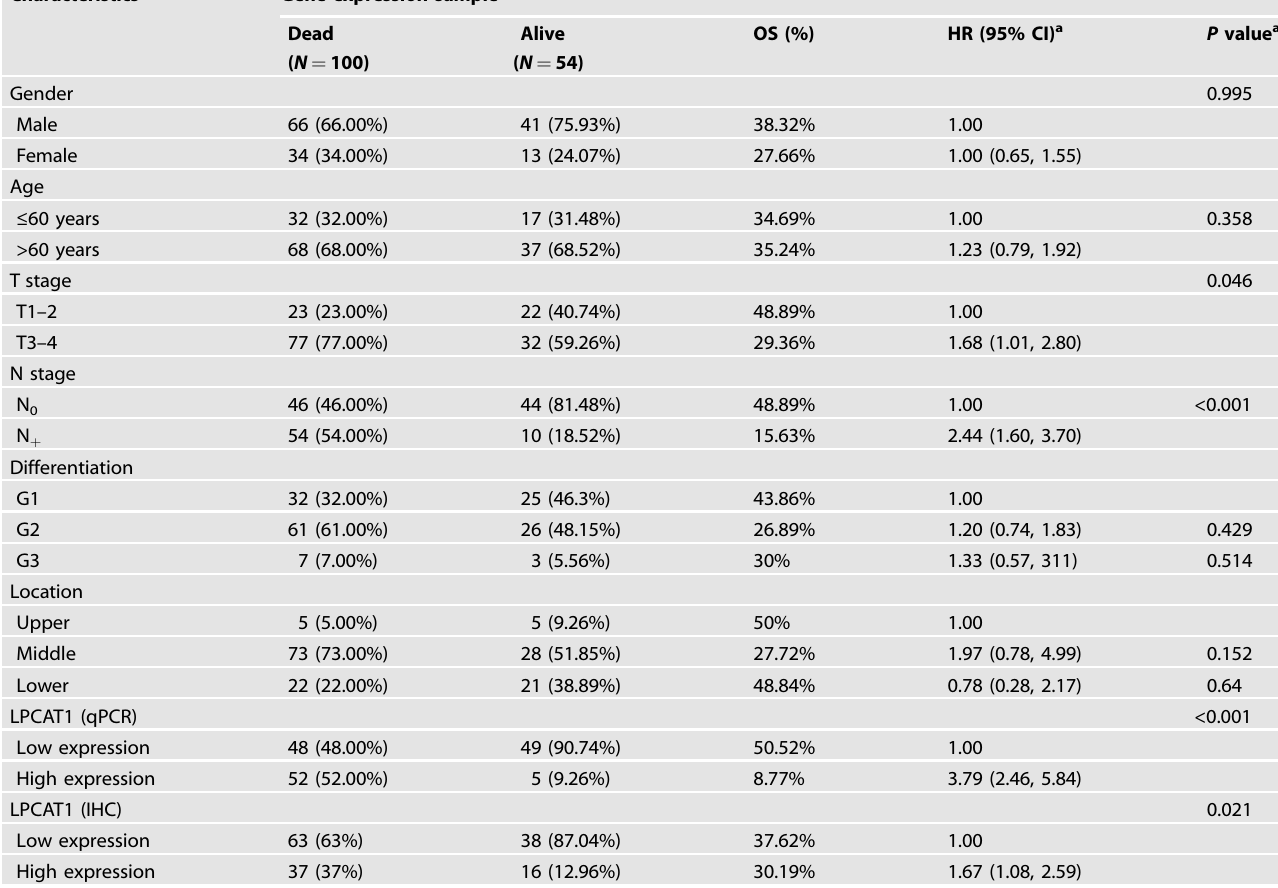
Table 1. Characteristics of subjects in screening and validation